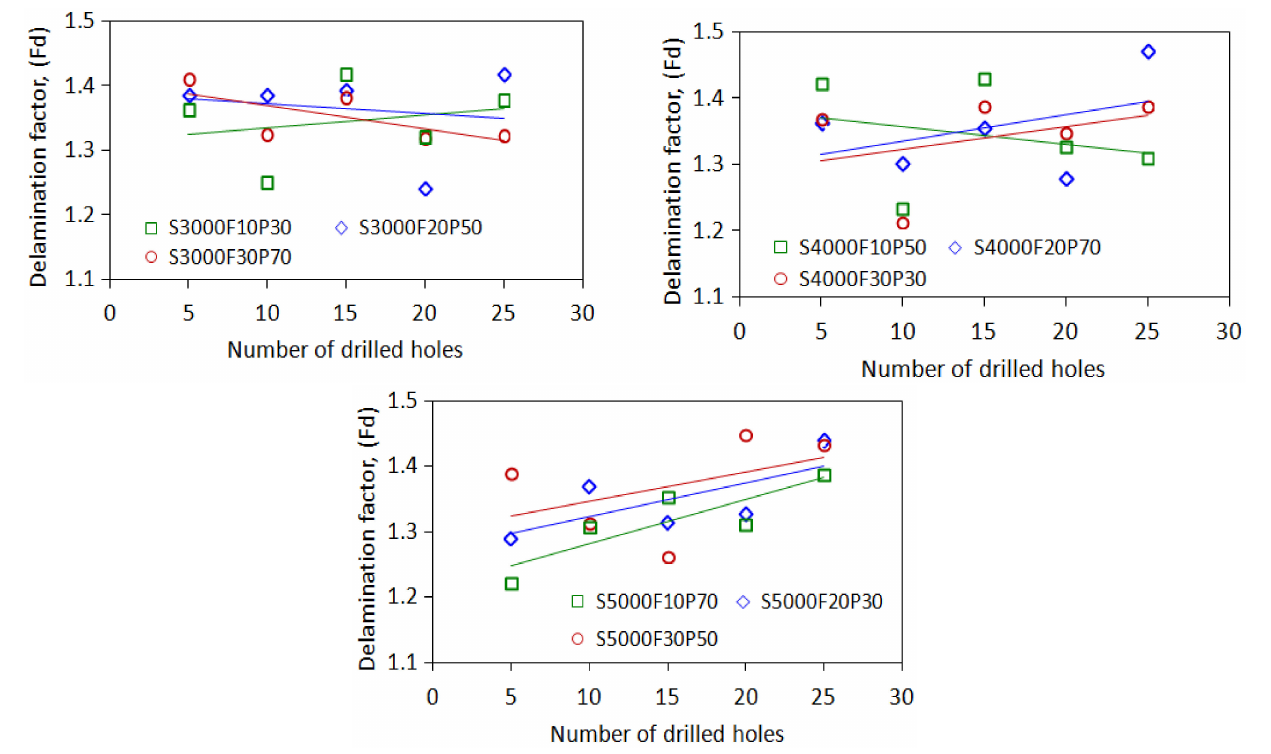
Figure 11. Variations in the delamination factor with drilling cycles. Table 5. Response table for the S/N ratios and ANOVA of the delamination factor.